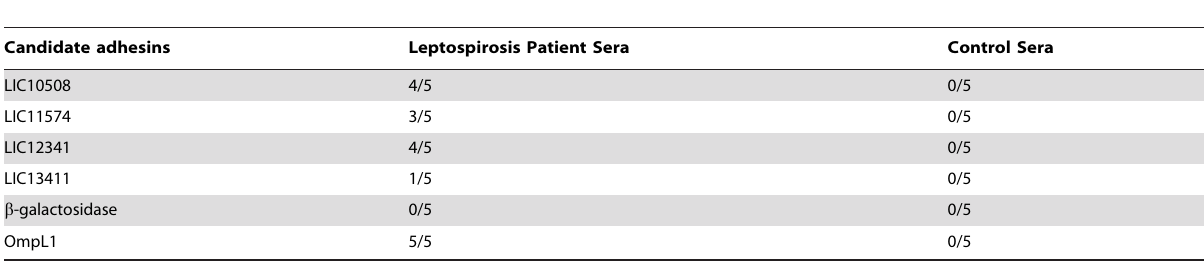
Table 3. Expression of candidate adhesins during Leptospira infection.